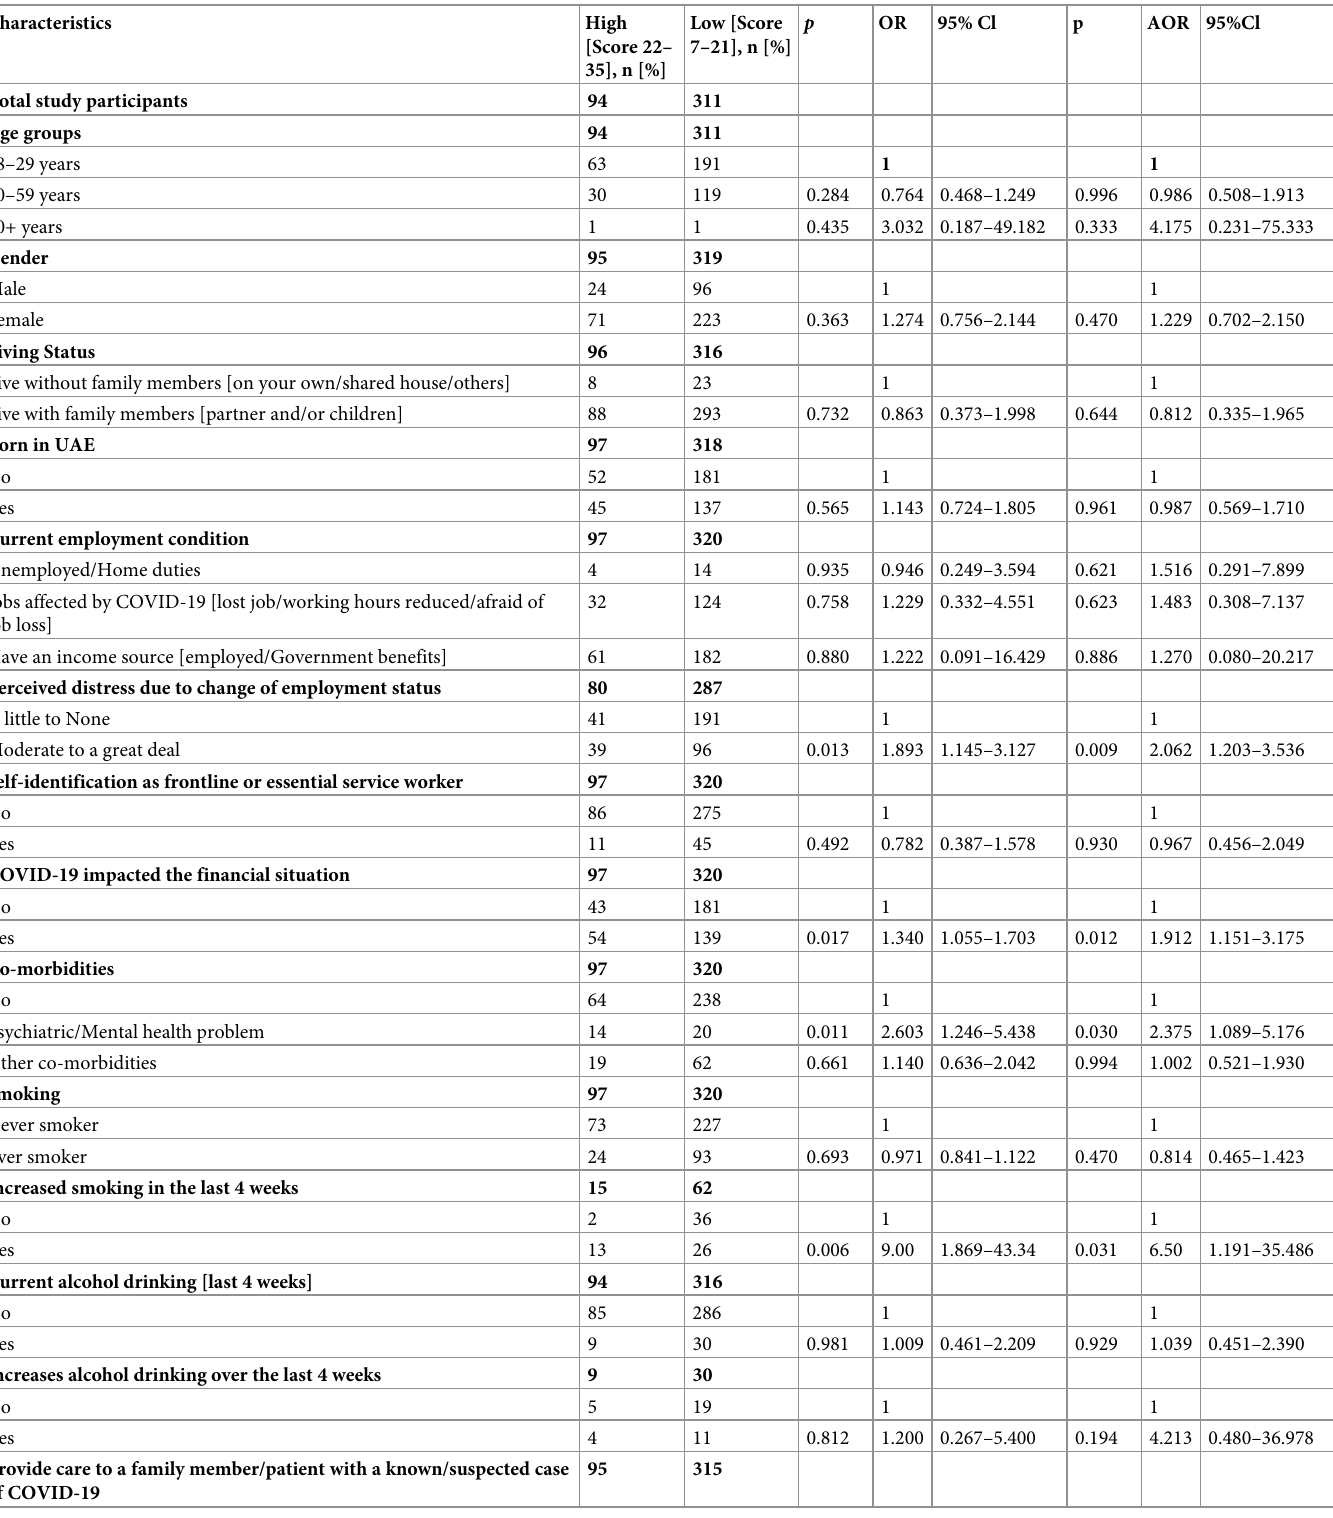
Table 3. Factors associated with levels of fear of COVID-19 among the study population [based on FCV-19S score] in UAE [November-2020].